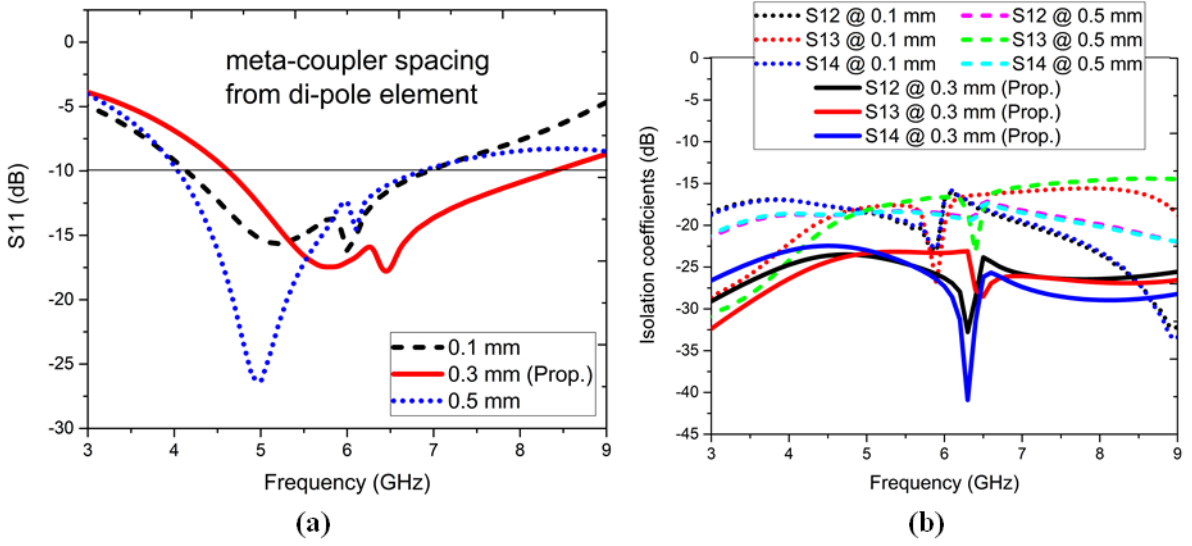
Figure 13. Variation of the distance between the dipole element and meta-coupler: ( a ) S11, dB parameter and ( b ) S12, S13, and S14 dB parameters.